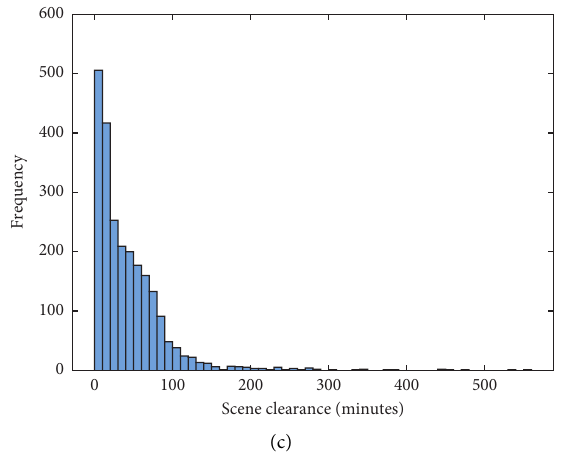
Figure 5: Above: map of the study area on I-64. VA shows the location and the number of incidents at each TMC (source: Google maps). Below left: histogram shows the categories of the reported incidents. Below right: histogram shows the distribution of the scene clearance times for all the 2365 incidents, which are the total during the analysis period.